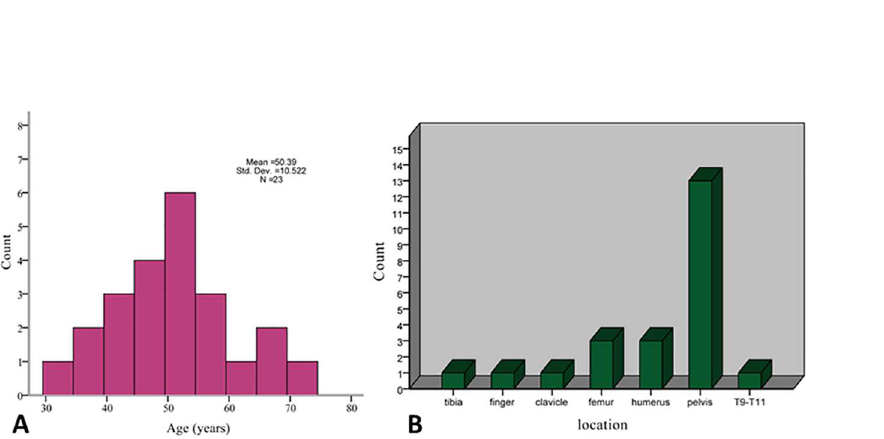
Fig 1. The distribution of age and location in 23 patients with dedifferentiated chondrosarcoma. (A) Age distribution. (B)